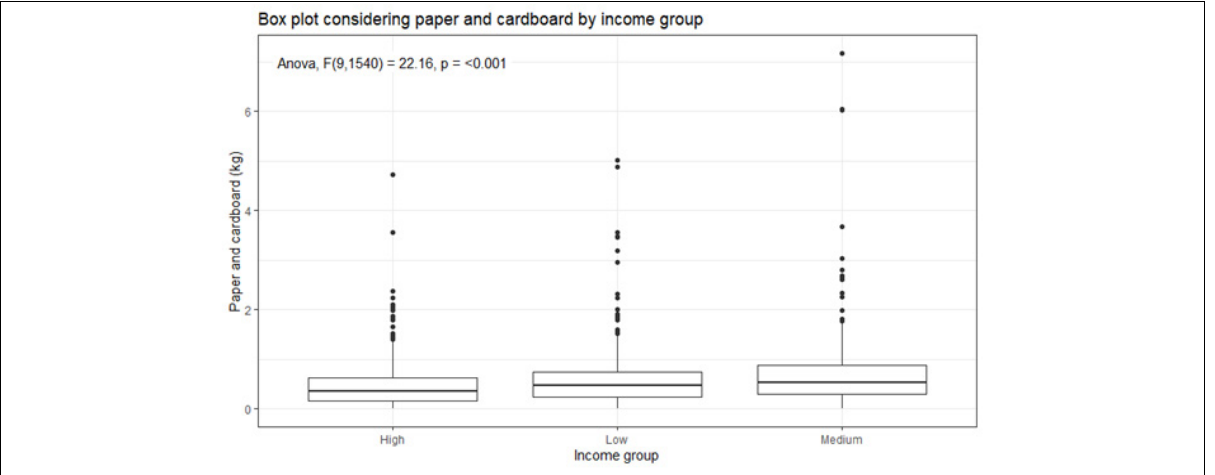
Figure 6: Box plot depicting differences in means of the paper and cardboard waste fraction between different income groups in Stellenbosch.